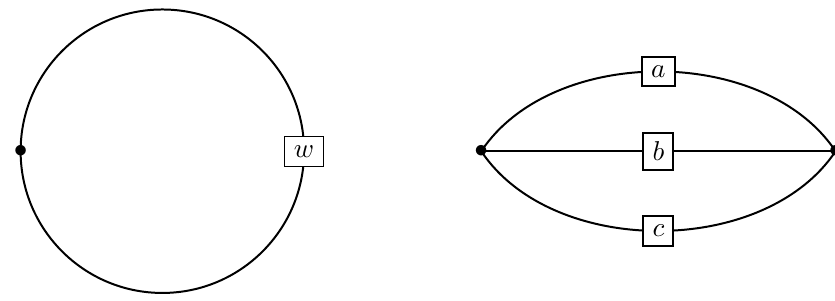
Figure 1 . The graphs corresponding to the one-loop and two-loop modular graph functions E w and C where a link with a boxed number w indicates w concatenated Green functions. a,b,c number of edges in the corresponding graph (which is also the number of Green functions in the chosen monomial). It is important to note that weight as defined here is distinct from modular weight, which is vanishing for all